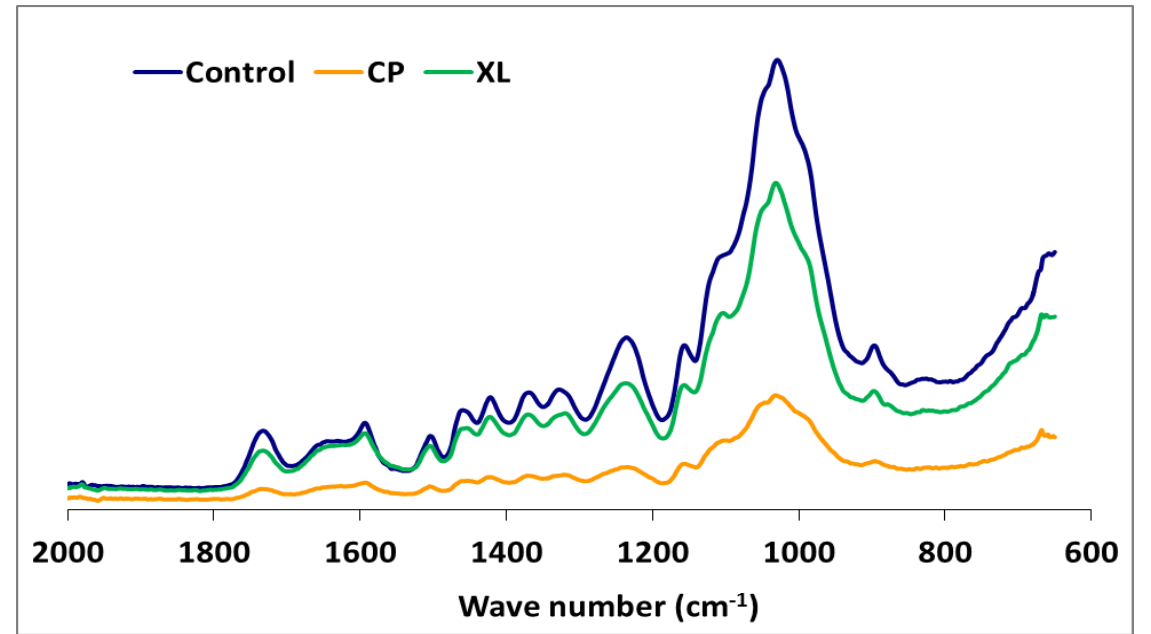
Figure 3. The comparison FTIR spectra of beech wood with or without exposure to Xylaria longipes (XL) or Coniophora puteana (CP).